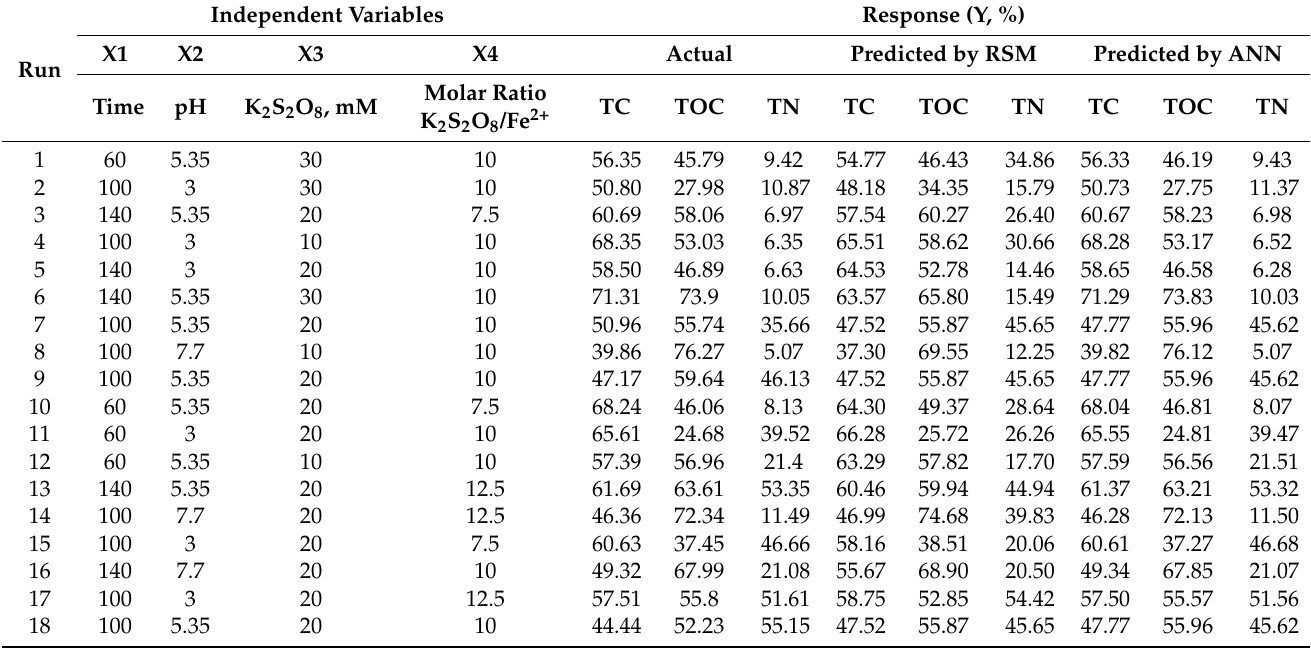
Table 1. Experimental matrix